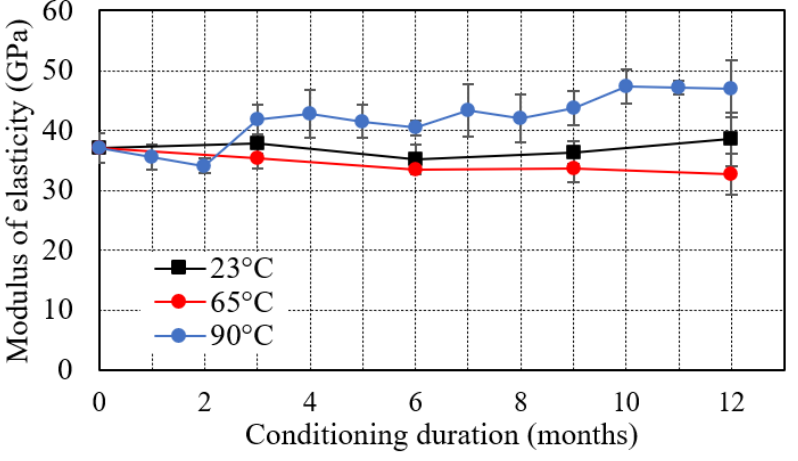
Figure 5. Effect of seawater immersion on modulus of elasticity.